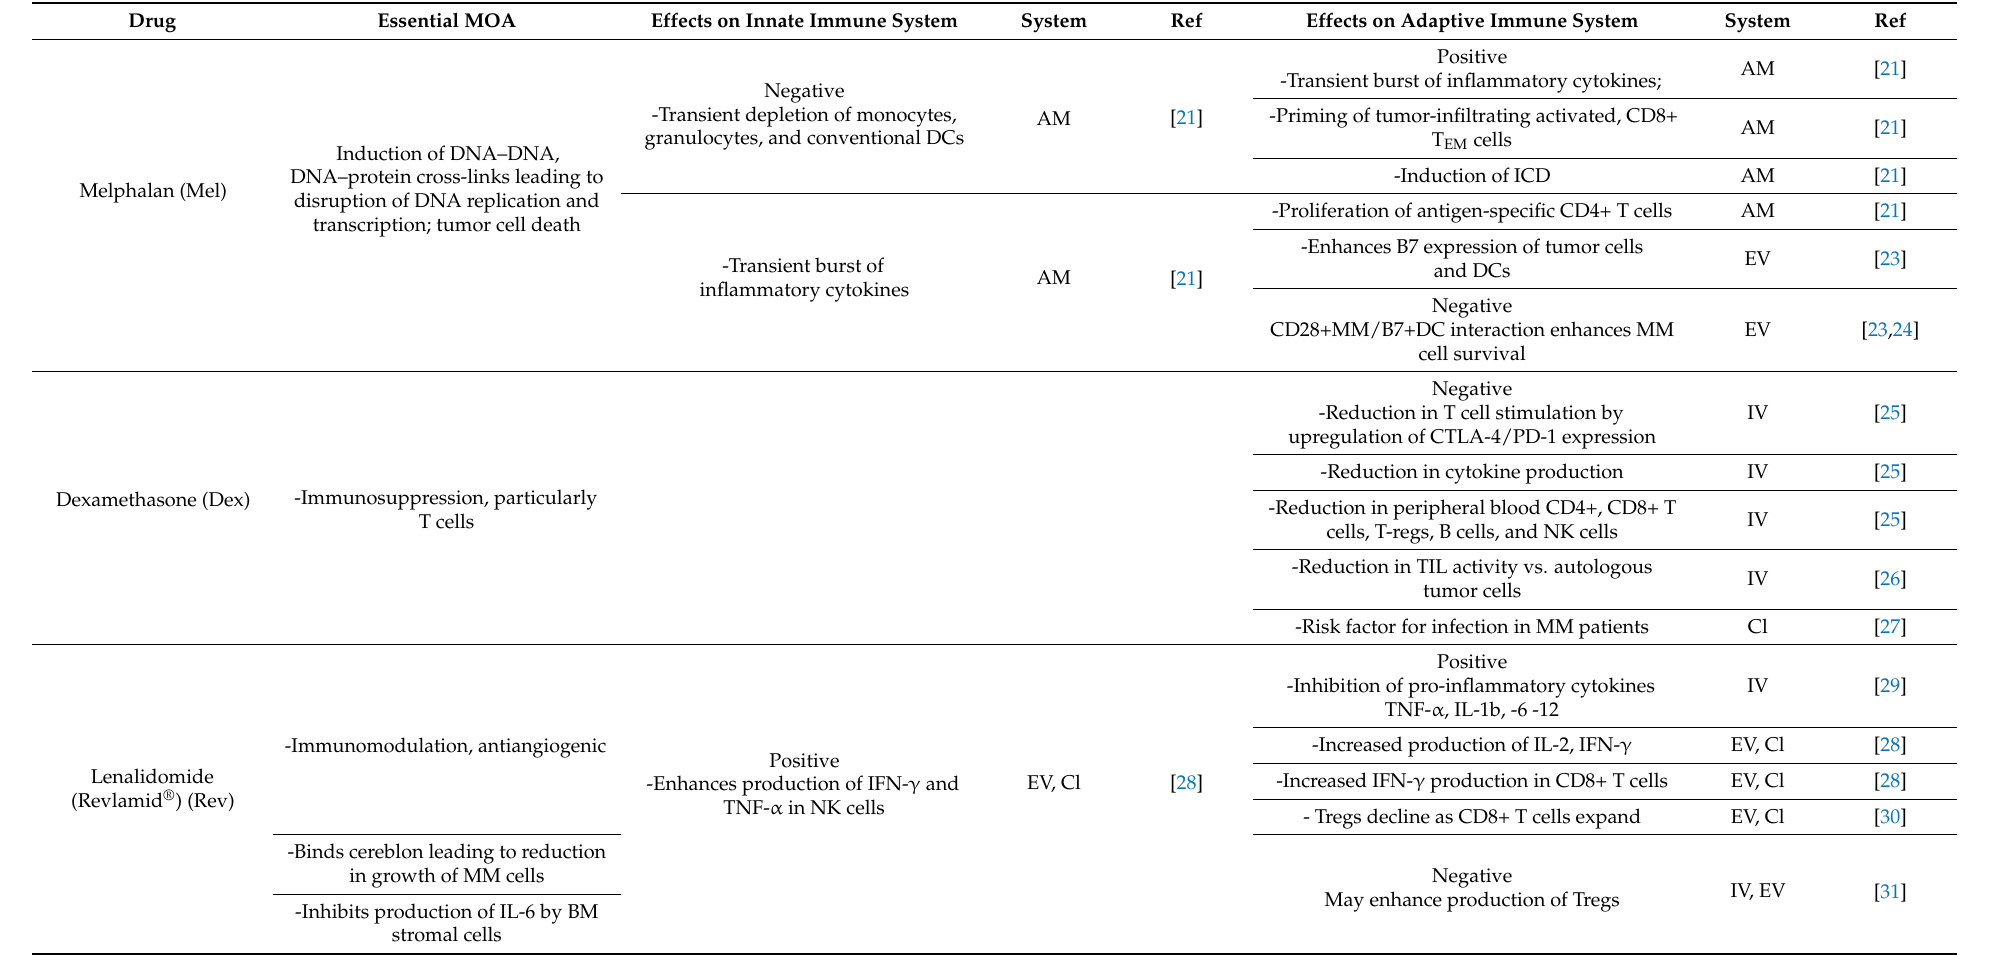
Table 1. Main effects on immune parameters of pre-ASCT induction drugs used to treat patients with Multiple